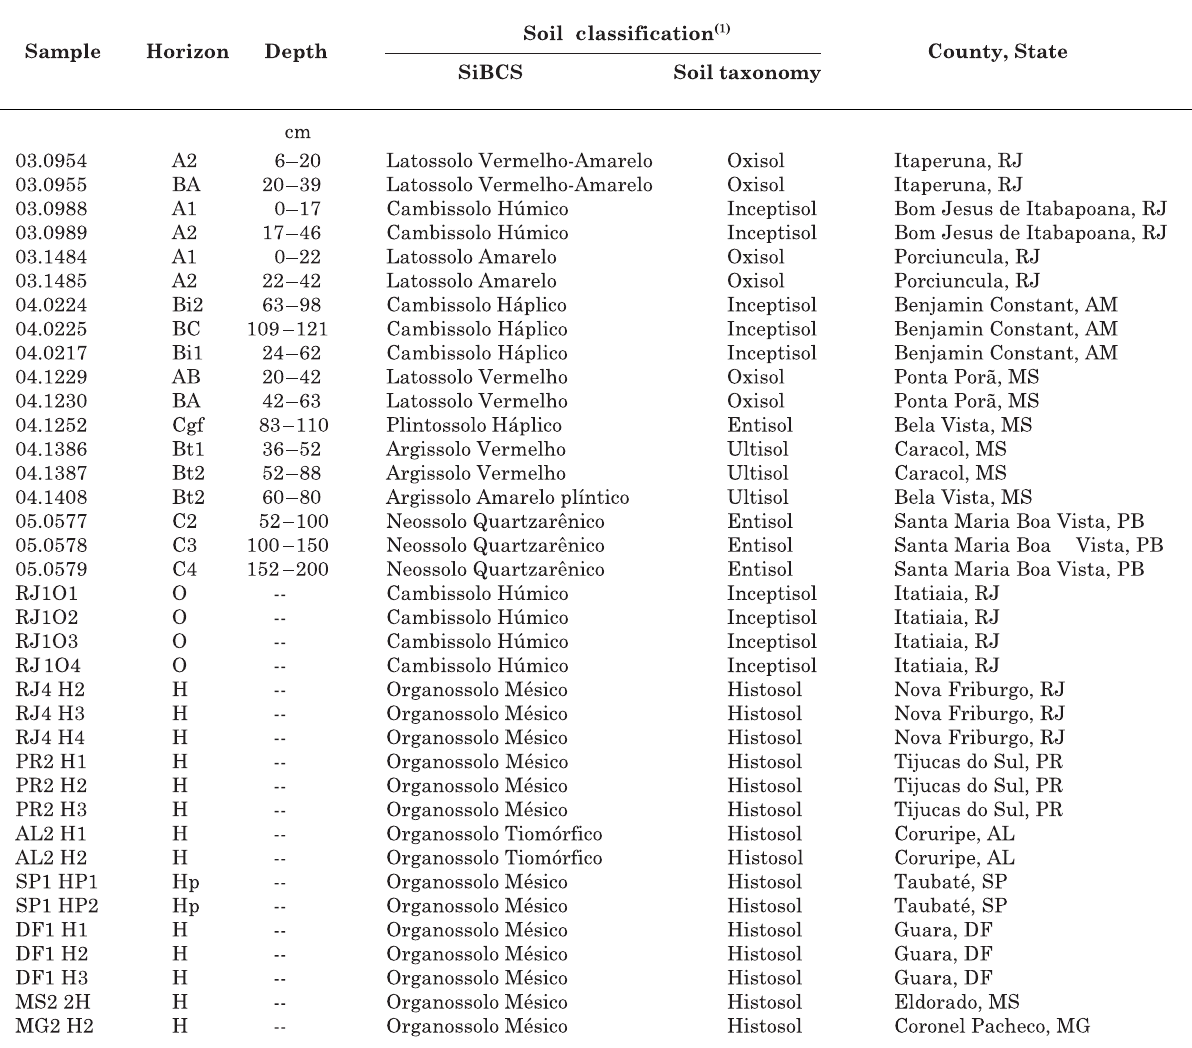
Table 1. Soil classification and localization of 37 selected soil